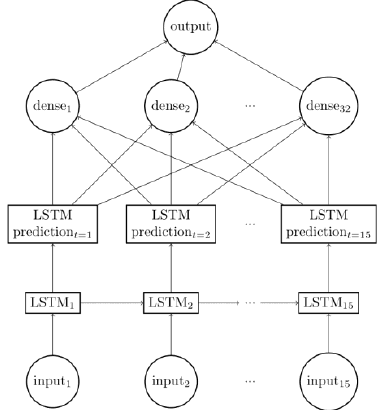
Figure 6. Best LSTM model.